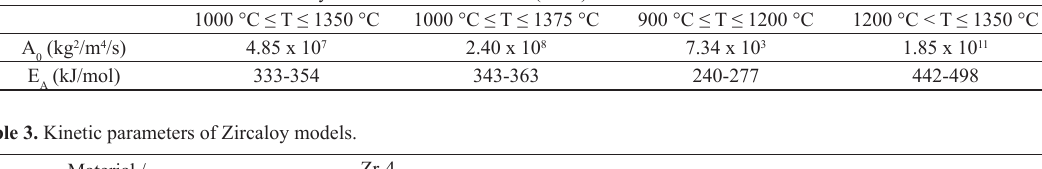
Table 2. Kinetic parameters of 304 SS models and the proposed model for AISI 348. Material / Kinetic Parameter